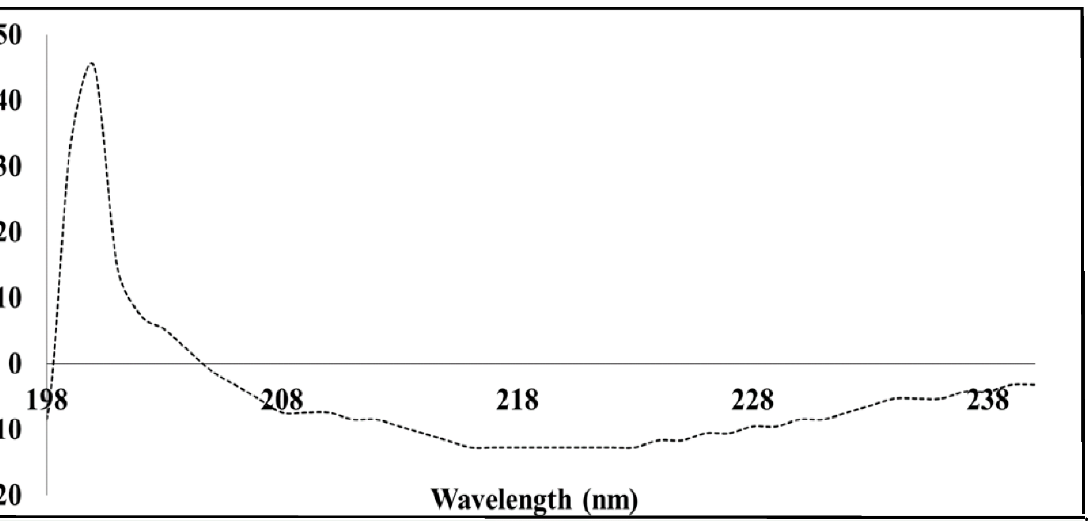
Figure 3. Far-UV CD spectrum of SACMV BC1. Signals were collected using 5 μM of protein in 0.5 mM Tris-HCl buffer, pH 7.5. The spectrum indicates that the protein displays a secondary structure which is predominantly β -strand.